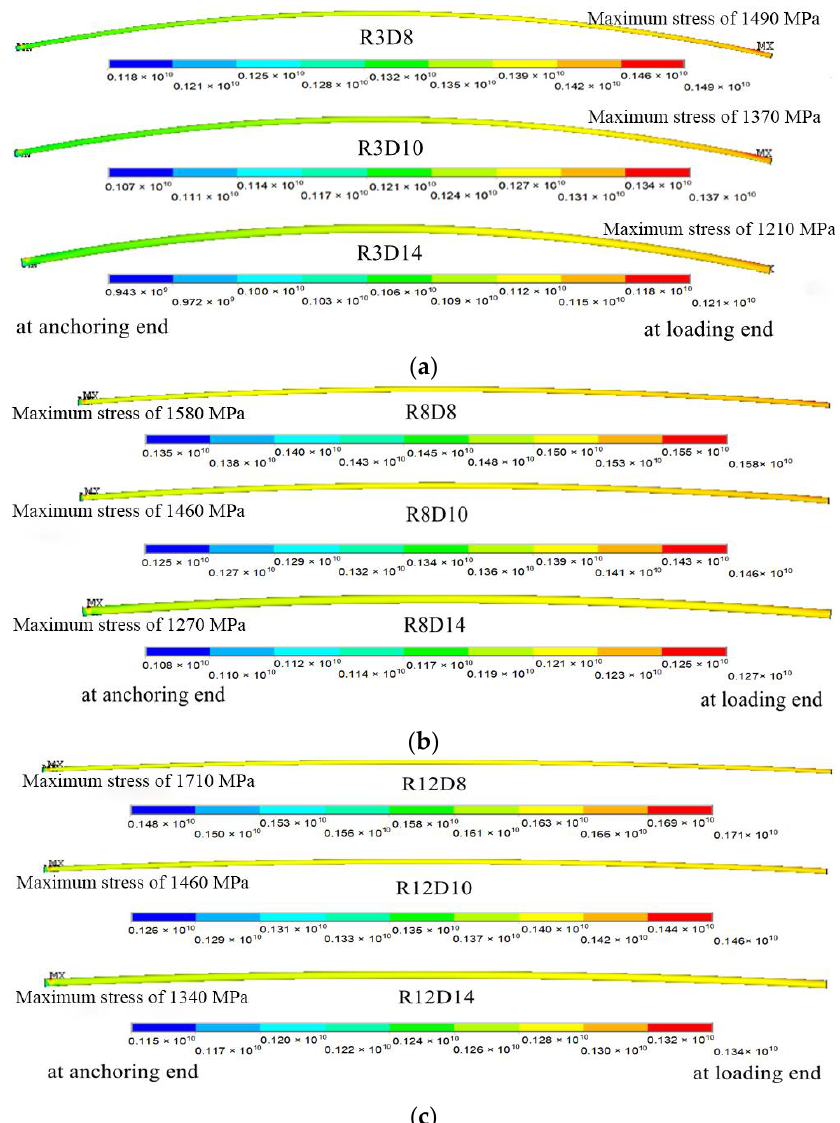
Figure 11. Stress distribution of CFRP tendons: ( a ) R3; ( b ) R8; ( c ) R12.